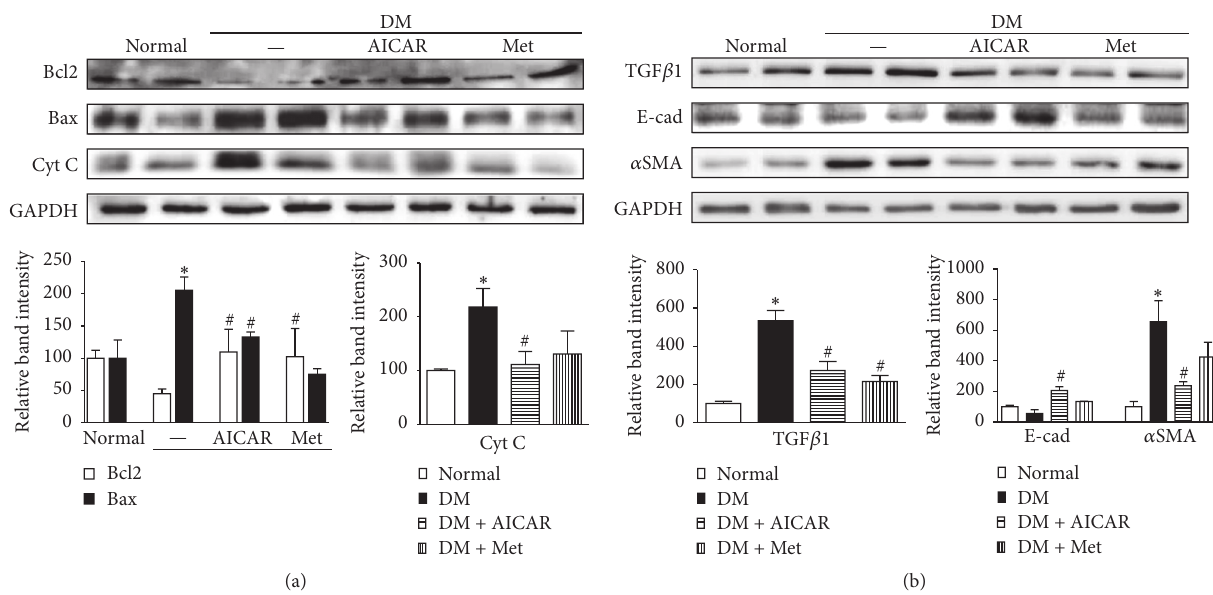
Figure 8: PGC1 𝛼 activators attenuate renal expression of apoptogenic and fibrotic proteins in STZ-induced diabetic mice. (a) In diabetic kidneys, the protein expression of the antiapoptotic protein Bcl2 was markedly decreased, whereas the expression of the apoptogenic proteins Bax and cytochrome C (Cyt C) increased greatly. PGC1 𝛼 treatment reversed the expression of these apoptogenic-related proteins. (b) Increased expression levels of TGF 𝛽 1 and 𝛼 SMA were seen in the kidneys from the diabetic group, and reduced expression levels of these proteins were seen in the AICAR- and metformin-treated groups. ( ∗ 𝑝 < 0.05 versus normal; # 𝑝 < 0.05 versus diabetic